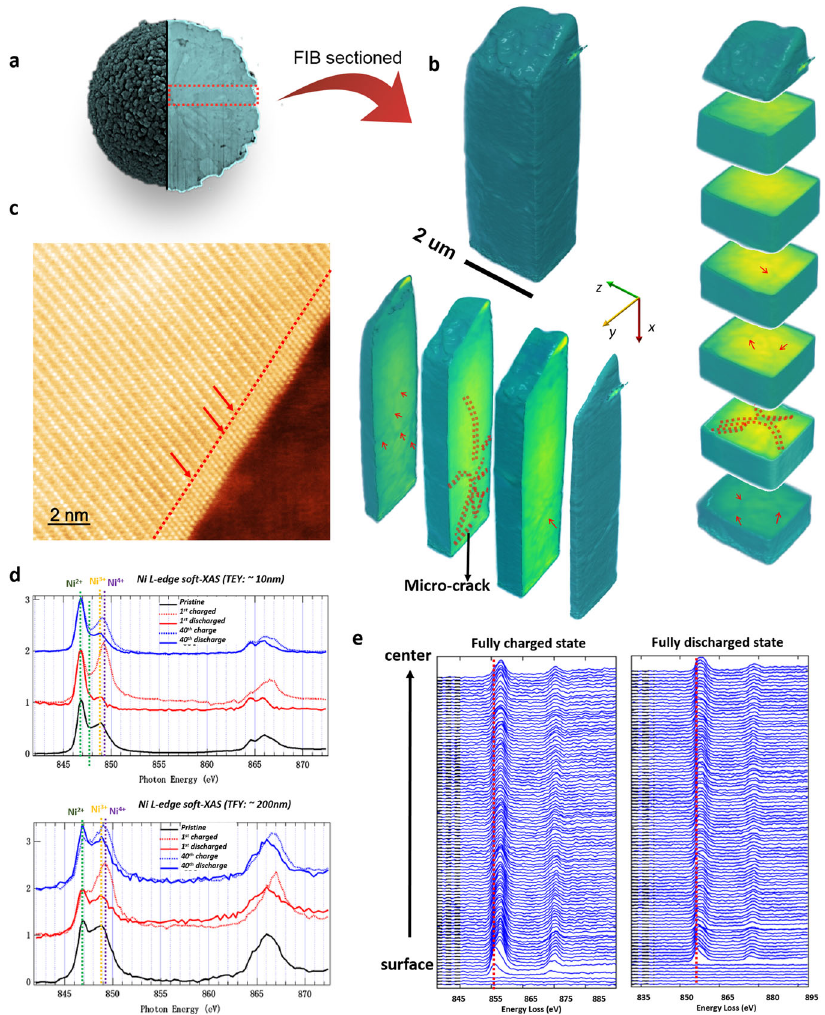
Fig. 3 Multi-scale length structure and chemical evolution of the valence gradient NMC811 material (VG-NMC811) after 40 electrochemical cycling. a Schematics of where the pillar was cut from the cycled secondary particle. b Three-dimensional X-ray tomography of the central pillar of a cycled secondary particle as marked in ( a ), which shows the formation of micro-cracks. c Atomic-scale HAAD-STEM imaging of the surface of an internal primary particle showing surface rock-salt reconstruction. d Soft X-ray absorption spectroscopy (XAS) of Ni L-edge for materials in pristine, after 1st cycle and after 40th cycle collected in total electron yield (TEY) and total fl uorescence yield (TFY) modes. e The electron energy loss spectra of Ni L 2,3 -edge from the surface to the center at charged state (4.4 V) and discharged state (2.7